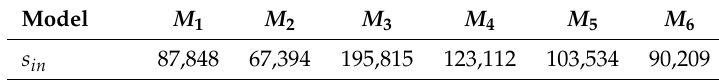
Table 1. The point clouds with number of points s in